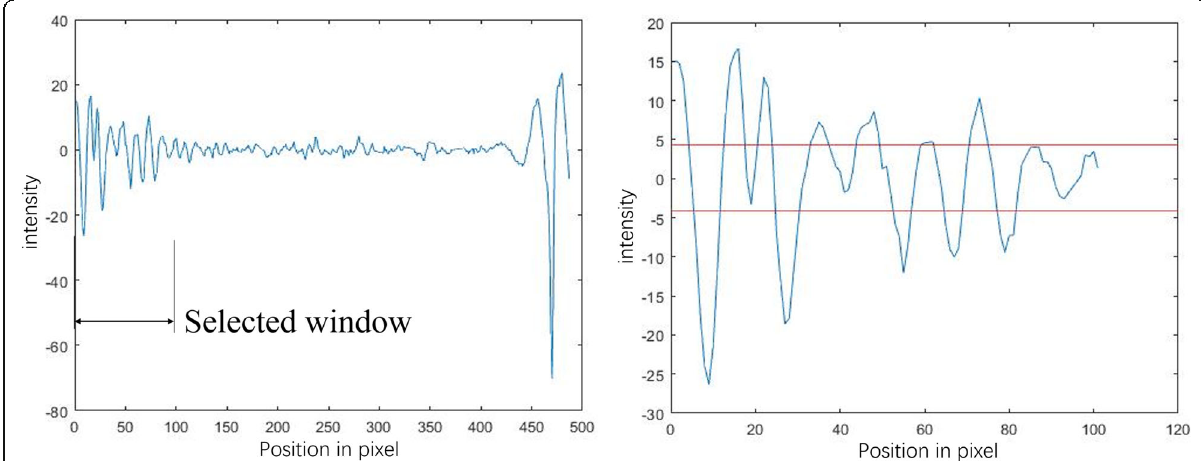
Fig. 4 One detrended row of data and an example of the peak/trough detection algorithm